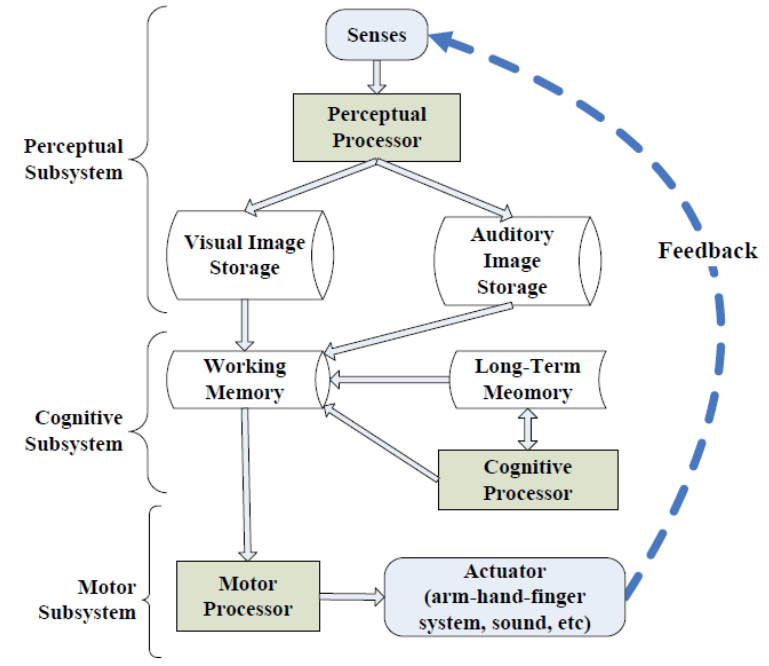
Figure 12. Framework of the model human processor